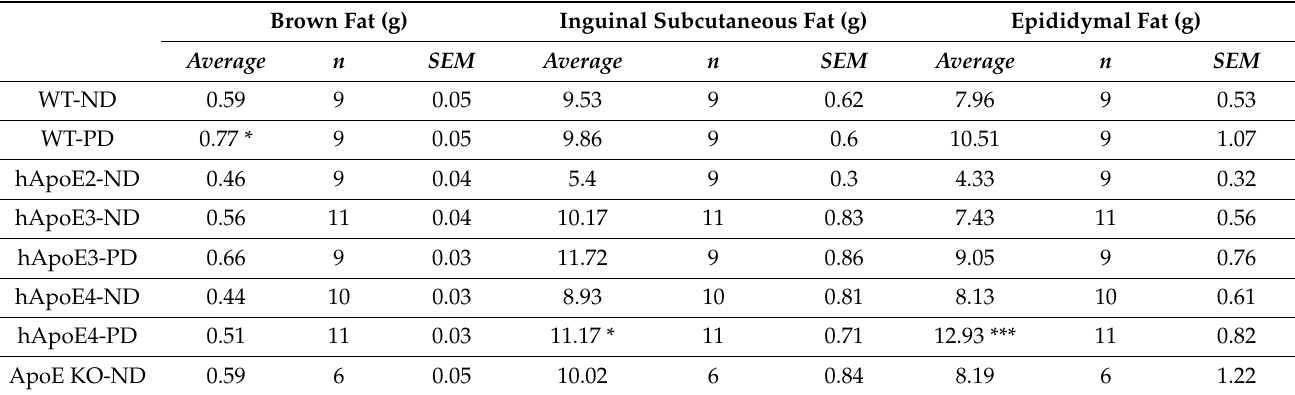
Table 1. Weight of adipose